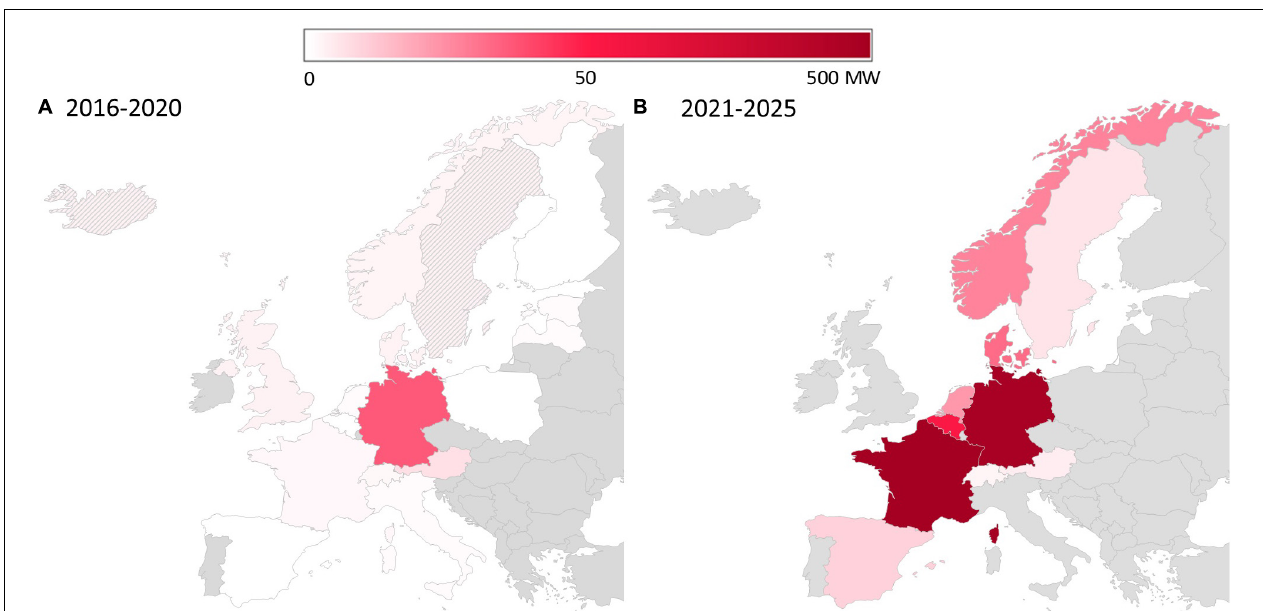
FIGURE 4 | Newly installed capacities of Power-to-X projects in Europe, (A) commissioned between 2016 and 2020, (B) planned for 2021–2025. Shaded countries: installed capacity not specified, gray countries: no Power-to-X projects.